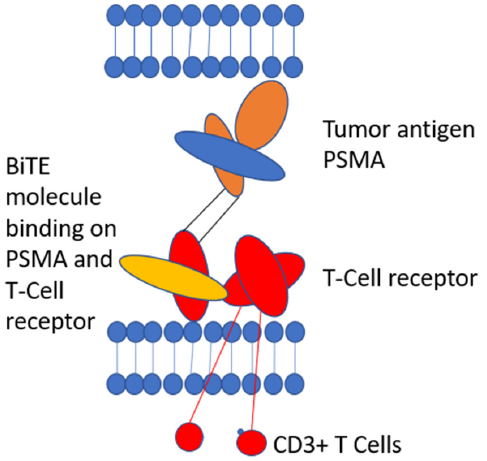
Figure 1. Bispecific T-cell engager. Modified according to Strohl et al. [42].